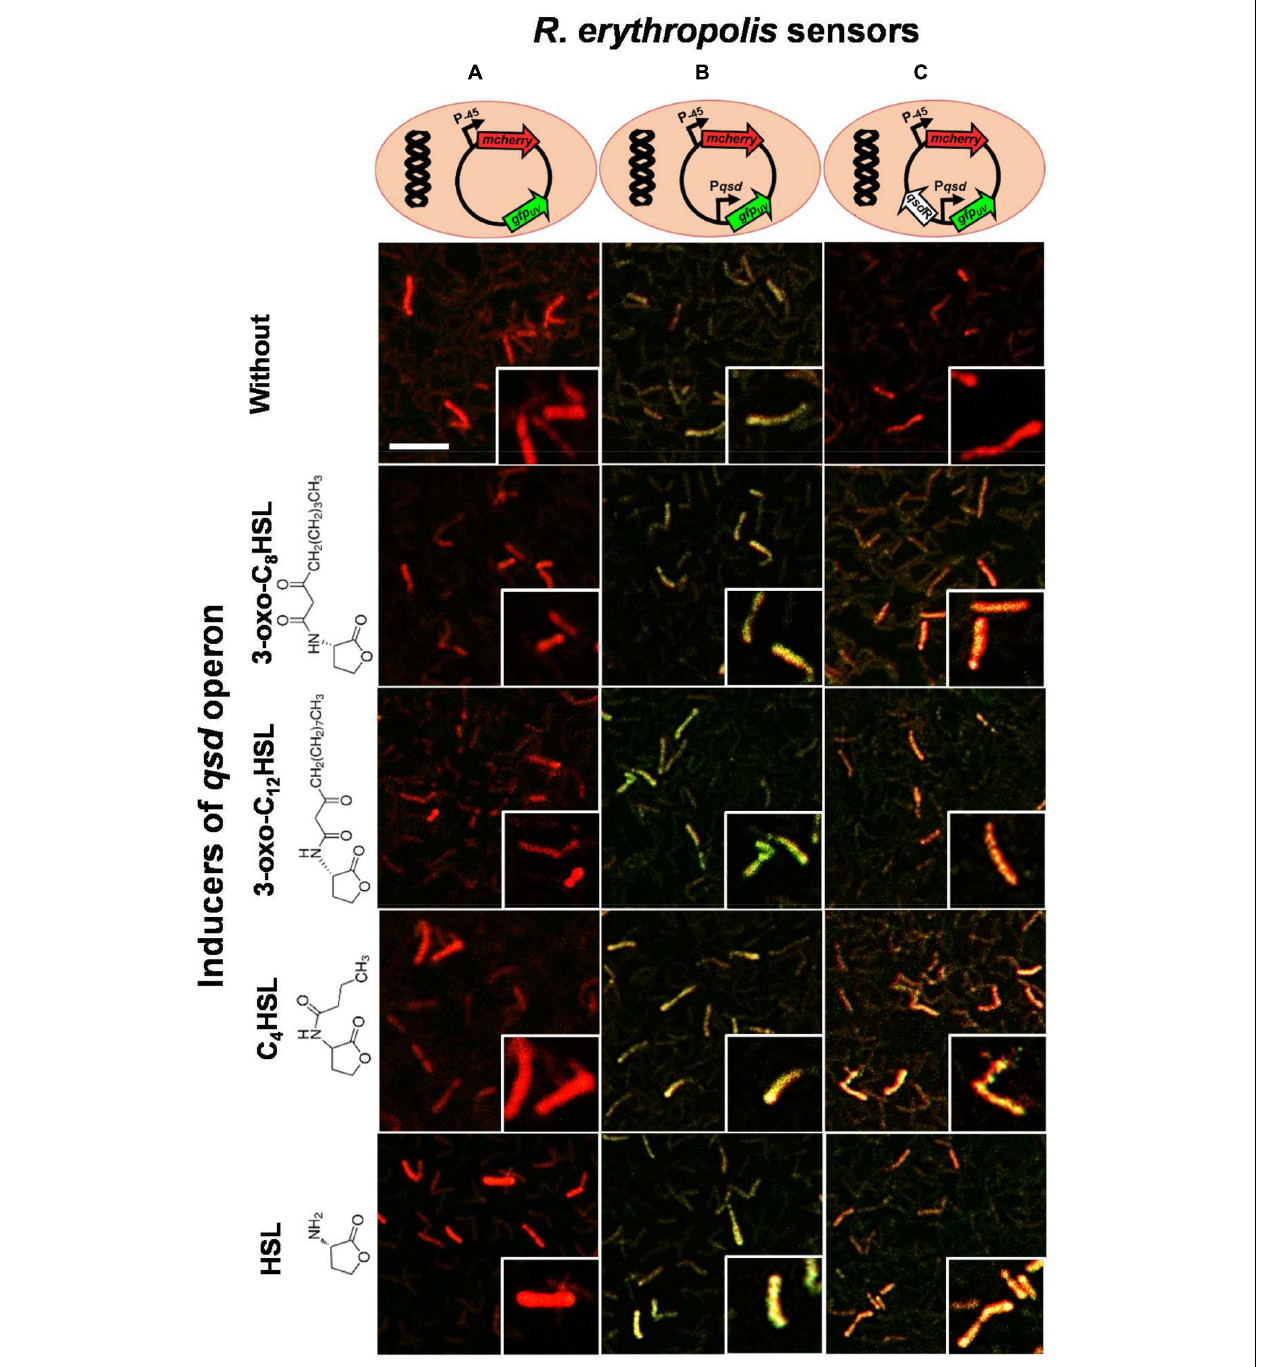
FIGURE 7 | Confocal microscopy analysis of the transcriptional activity of the qsd operon. Three dual-colored R. erythropolis R138 sensors were constructed using the pEPR1 vector containing a green fluorescent protein gene as reporter gene and a red fluorescent protein mcherry gene as a cell tag. These strains carry (A) the gfp gene without promoter (as a control), (B) the gfp gene under control of the qsd promoter, and (C) the gfp gene under control of the qsd promoter and QsdR regulator (mimicking the regulation system of qsd operon expression). Rhodococcal cells were cultured in hexanoate minimal medium and harvested every 2 h after the addition of one micromolar of 3-oxo-C 8 -HSL, 3-oxo-C 12 -HSL, C 4 -HSL, or HSL. Cultures in hexanoate without inducer were used as control. Map of each designed vector are schematized at the top of the figure and the structure of inducers with the common γ -lactone ring is drawn on the left of the figure. Fluorescence images were combined in the green and red channels (see section “Materials and Methods”), the co-expression of the two fluorescent proteins causing a yellow-greenish to amber fluorescence depending on the intensity of gfp expression. A close-up of some cells is proposed in a lower right window. Scale bar represents 10 µ